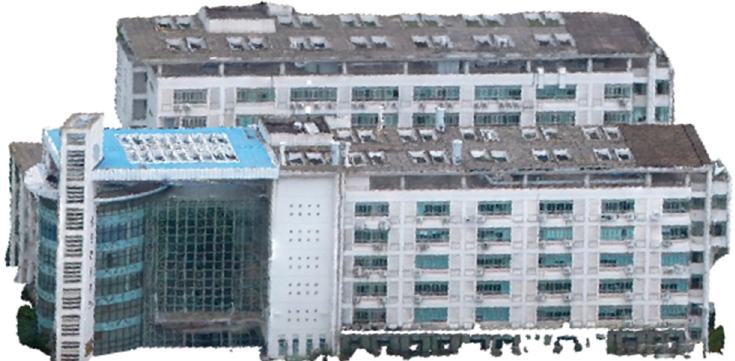
Figure 16. Building B point cloud before filling.